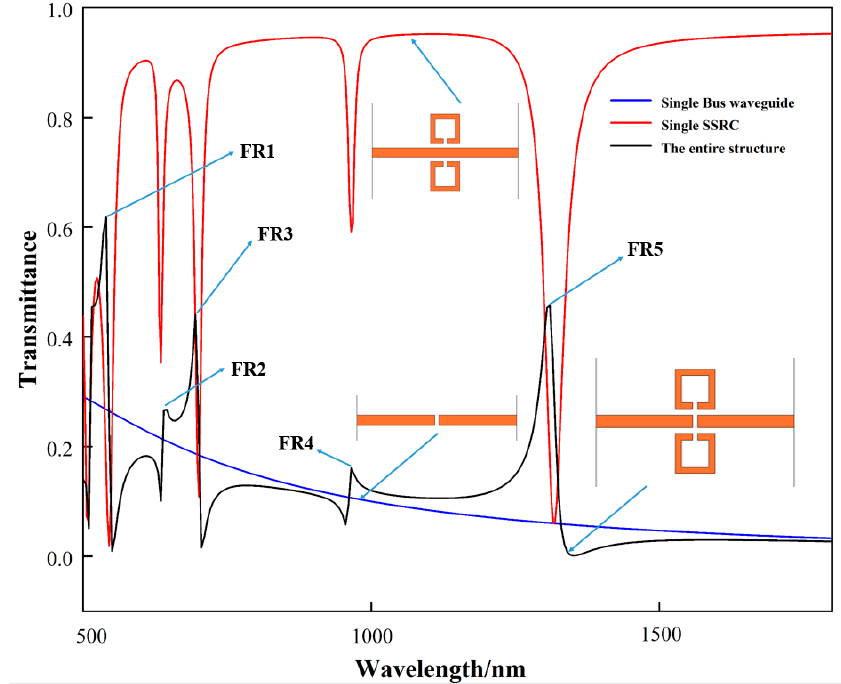
Figure 2. Schematic diagram of the formation mechanism of Fano resonance excited by the designed structure.